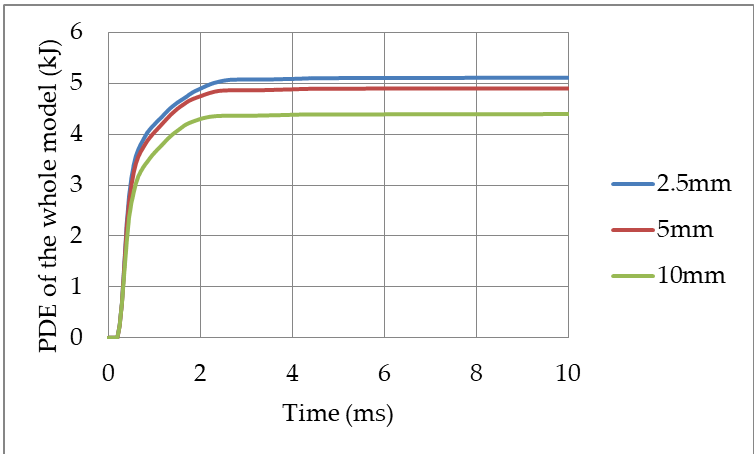
Figure 7. Variation of the Plastic Dissipation Energy (PDE) of the whole model with respect to mesh size 2.5 mm, 5 mm, and 10 mm, for the trapezoidal sandwich panel subjected to 0.5 kg of TNT at R = 0.5 m (BI-5).